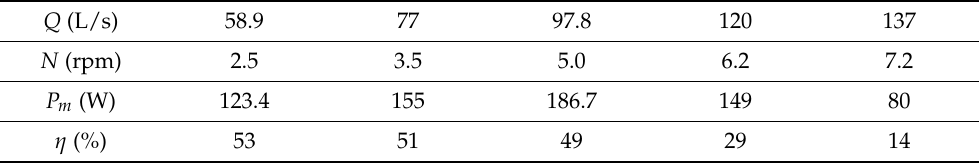
Table 1. Operating points of the HPM with straight blades of 1200 mm in diameter, based on experimental